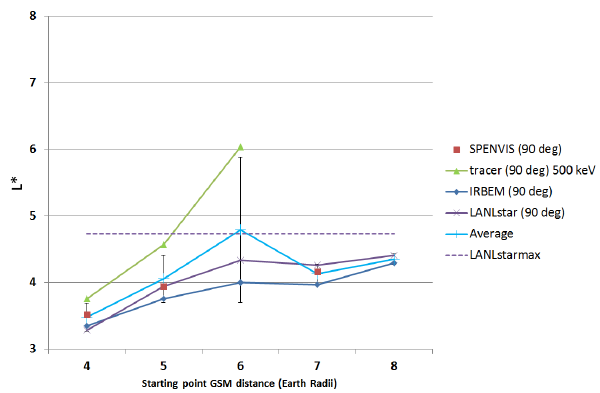
Figure 7. Calculations of L ∗ as a function of initial distance (in R E ) at 00:00MLT, for an initial pitch angle of 30 ◦ during disturbed solar wind conditions. Error bars represent the standard deviation between results from the various models.